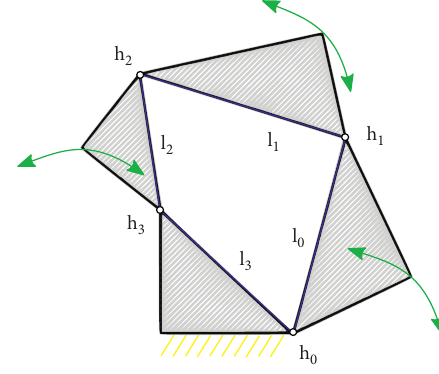
Figure 3: Four bar